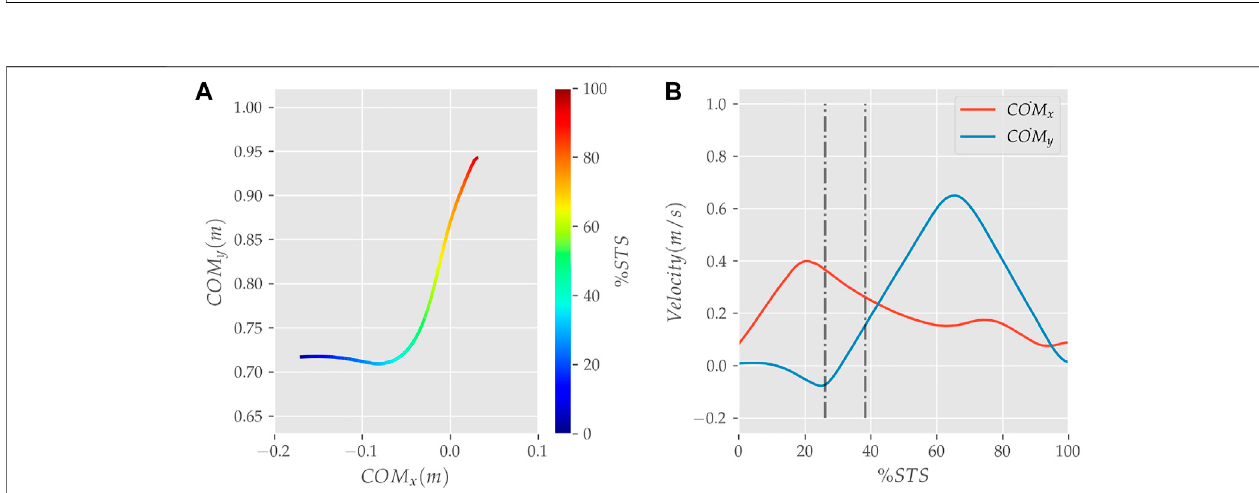
FIGURE 8 | (A) Evolution of COM position and (B) velocity for the 0% strength de fi cit model ’ s STS transition.